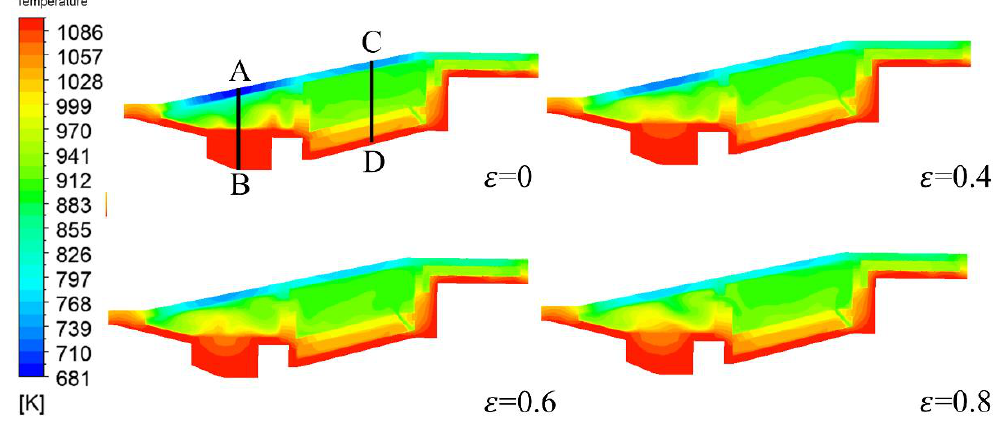
Figure 17. Temperature contour of the X–Y section of the casing for different emissivities. As shown in Figure 18, the temperature distributions with different surface emissivities are plotted. Point A on the transversal AB represents the point of the dimensionless distance of 0, and point B represents the point with the dimensionless distance of 1. Similarly, points C and D represent the points with the dimensionless distance of 0 and 1, respectively. The line segment with drastic changes in the figure represents the conversion between the cavity and wall temperatures. It can be seen that with the increase of the emissivity, the temperature in the closed annulus cavity decreases. The effect of the emissivity on the temperature in other cavities is not apparent. Within the range of 0.2–0.5 of the AB transversal, the temperature of the cavity without wall surface radiation is lower than that of the cavity with wall surface radiation. The main reason is that the radiation promotes heat transfer between wall surfaces. Furthermore, with the emissivity increment, the cavity’s temperature near the gas side increases while the temperature near the bypass decreases.